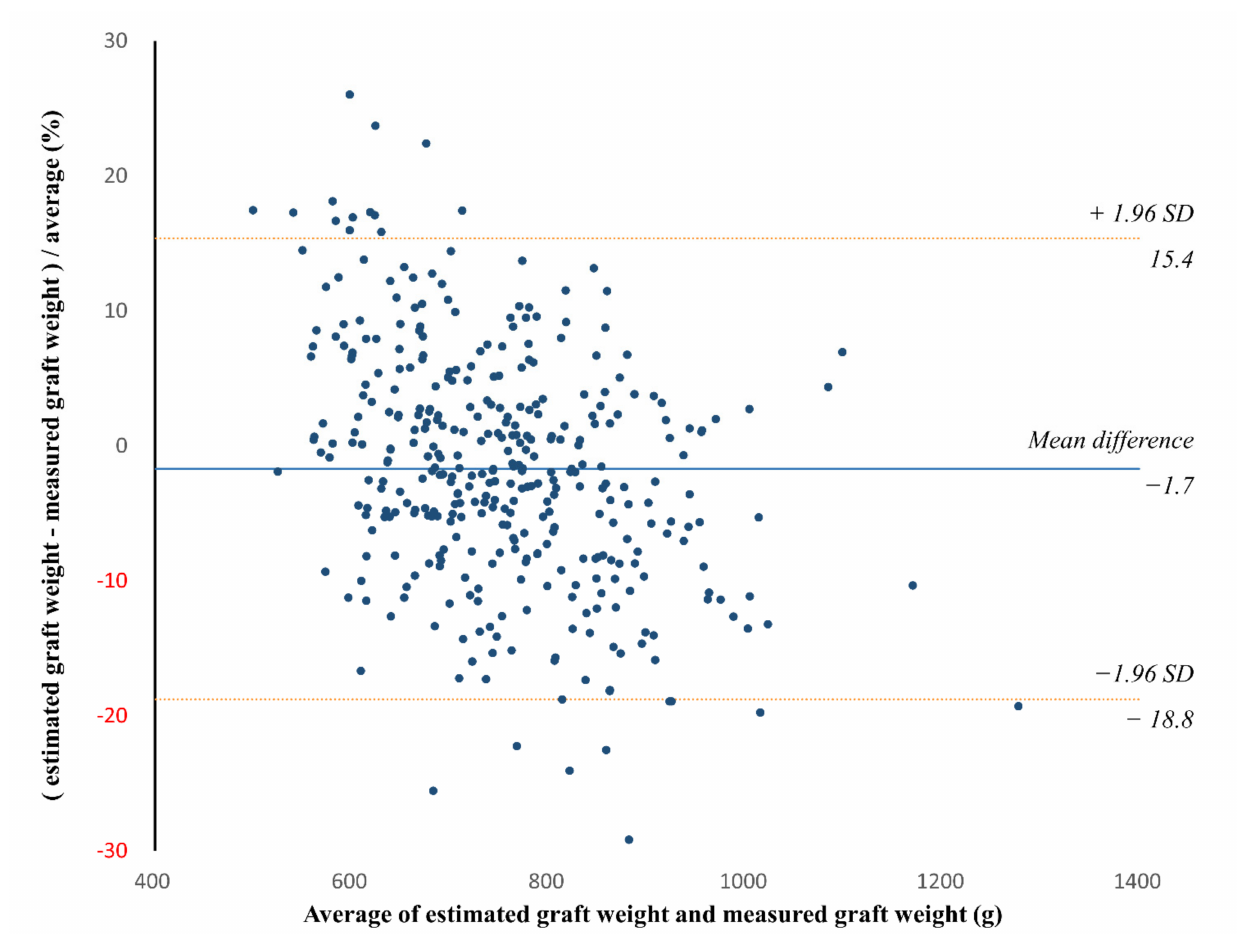
Figure 5. Bland–Altman plot of the agreement between the estimated and measured graft weights in the validation group. The solid line indicates the mean difference, while the dashed lines indicate the upper and lower limits of the 95% limits of agreement. The Bland–Altman 95% limit of agreement (LOA) was − 1.7% ± 17.1% ( p = 0.002 for the difference of mean bias from zero). SD = standard